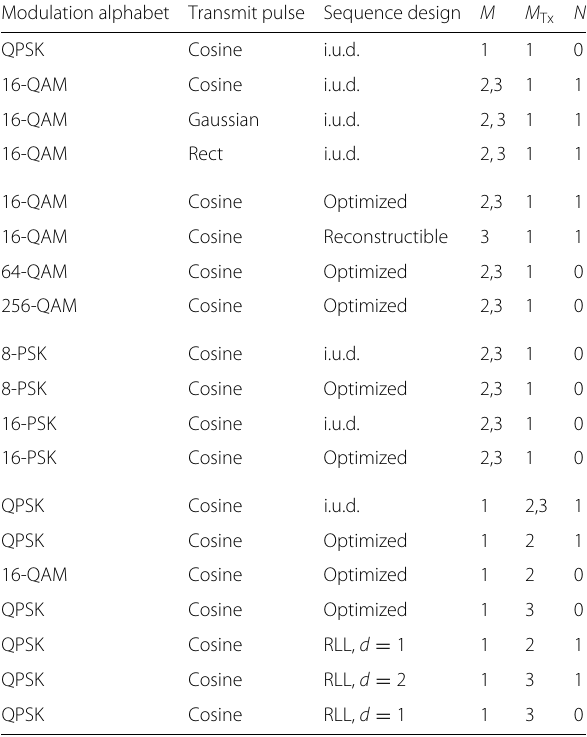
Table 3 Overviewonconsidered scenarios with 1-bit quantization at the